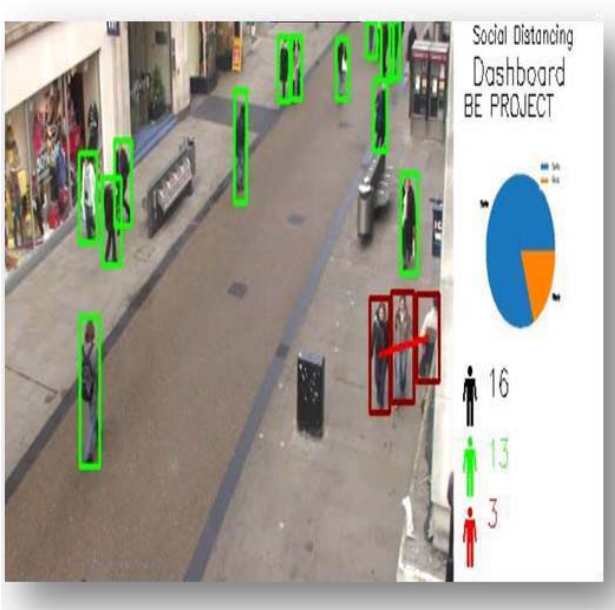
Fig 5.1: Social distancing violations < Threshold value